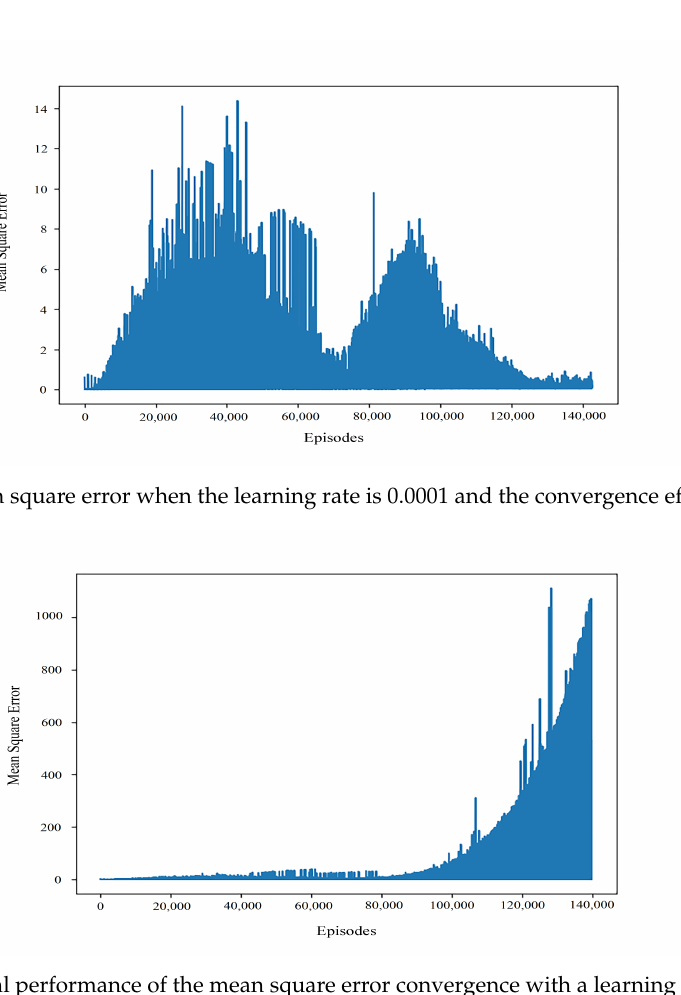
Figure 6. General performance of the mean square error convergence with a learning rate of